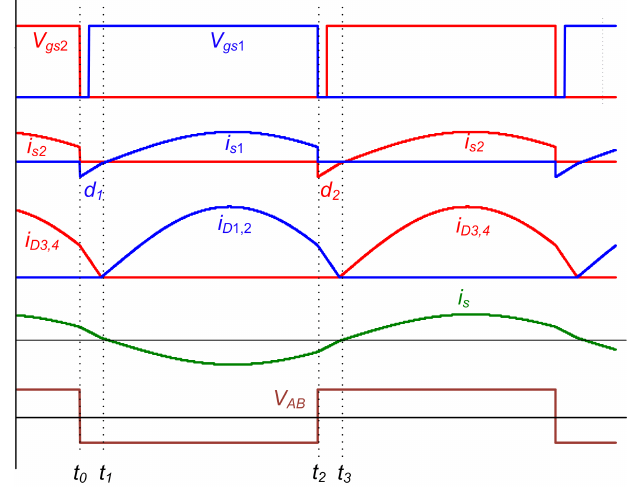
Figure 2. Steady state